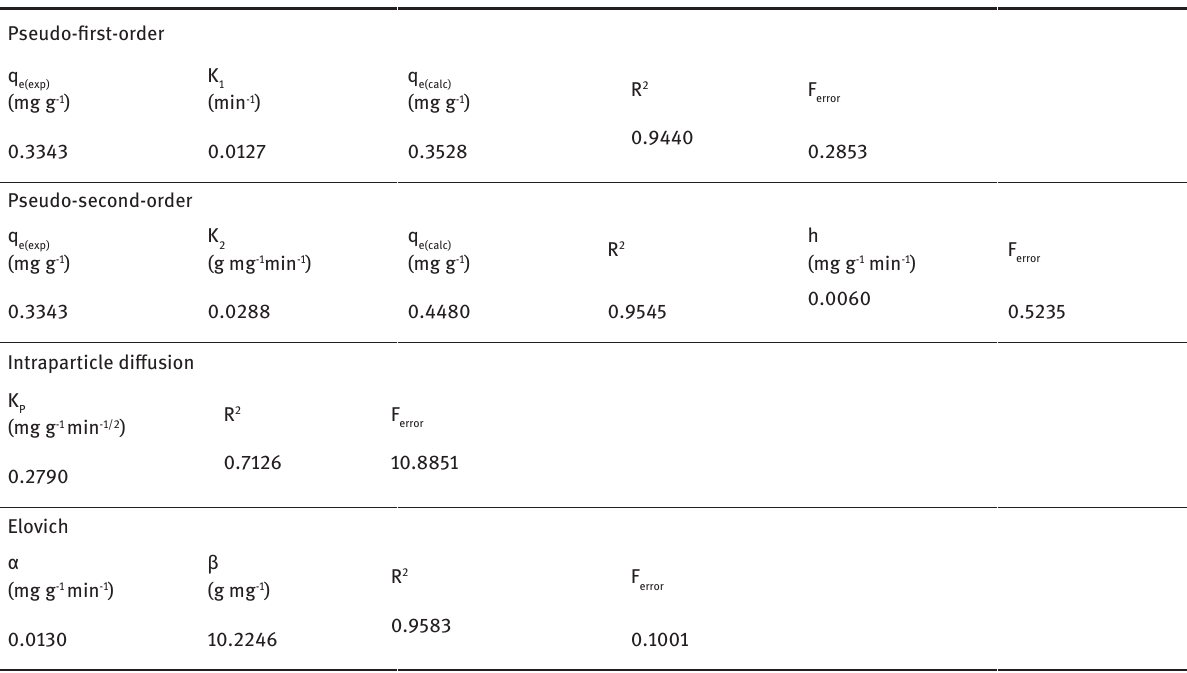
Table 1: Kinetic parameters obtained with the different models for adsorption of 30.0 mg L -1 of the reactive red RB dye in the cellulose matrix, pH 2.0, T =